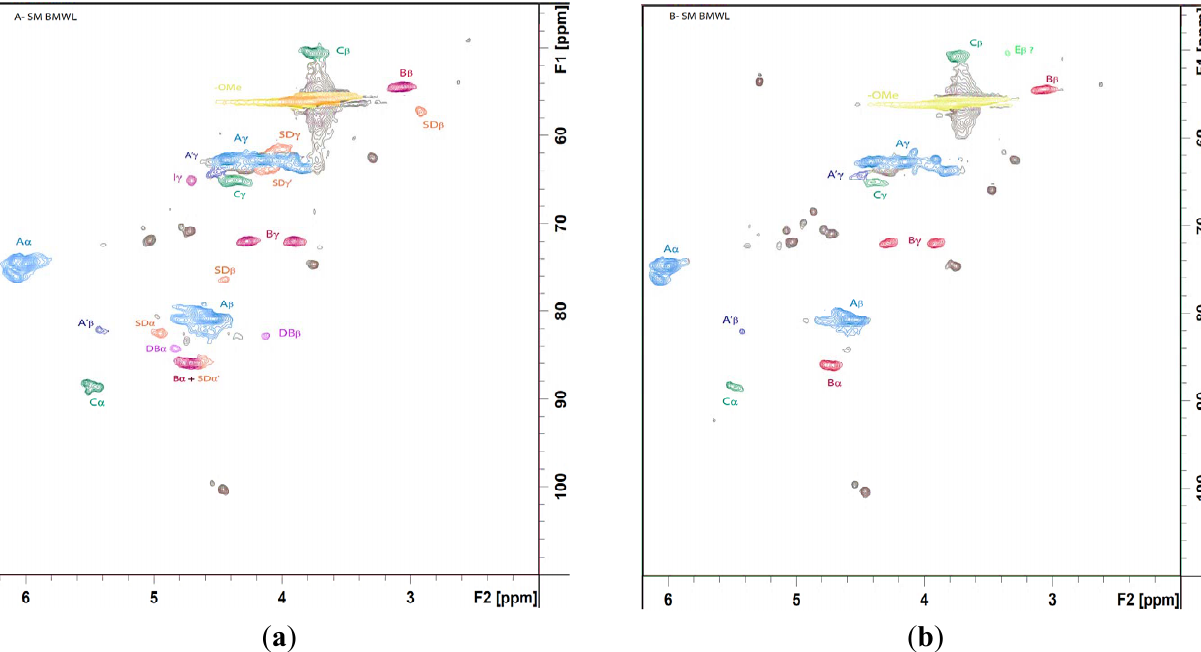
Figure 4. HSQC spectra of the side chain of SM MWL: ( a ) MWL_SM_AW; and ( b ) MWL_ESM_DCM depicting lignin linkages. The colors and alphabetical nomenclature of the contours correspond to substructures shown in Figure 2.